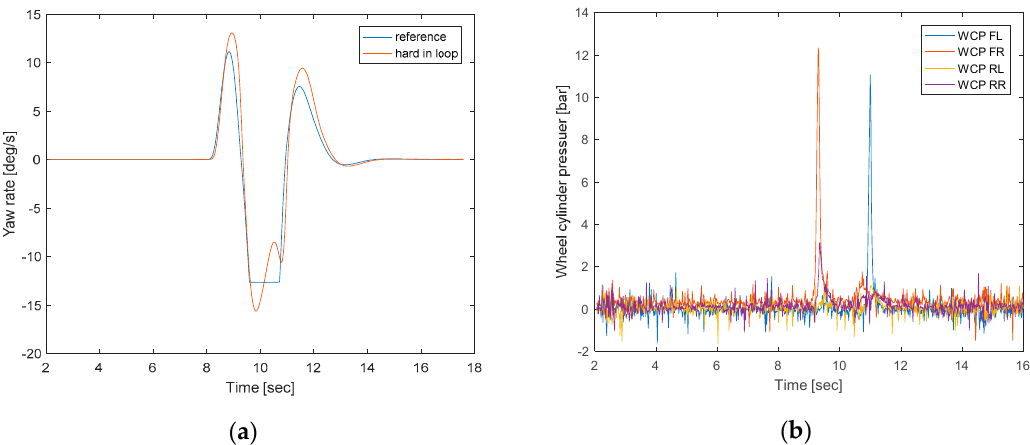
Figure 13. Test results based on the tire force observation controller at 𝑢 = 80 km/h and 𝜇 = 0.5. ( a ) is a comparison of the nominal and actual values of the yaw rate, and ( b ) is the wheel cylinder pressure value collected from the wheel cylinder pressure sensor.